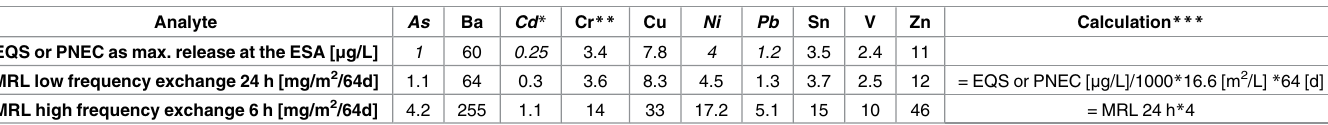
Table 1. MRLs for two different scenarios based on the EQS or PNEC and the model deduced as explained in the previous section. Italic = EQS, rest = PNEC as explained in the previousparagraph( * basedon class 5, water hardness (cid:21) 200 mg CaCO 3 /L), ** as Cr(VI), *** as explained in Fig 1).